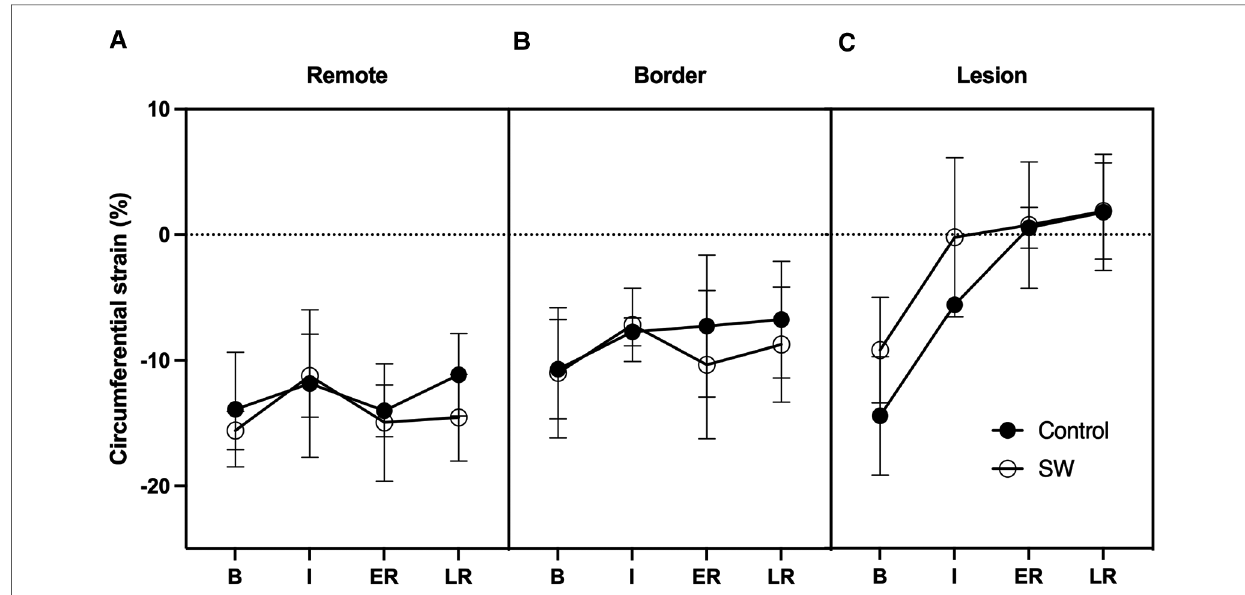
FIGURE 5 Circumferential regional Strains time-course at Baseline ( B ), Ischemia ( I ), Early (ER) and Late Reperfusion (LR) in Control Group (black dots) and SW Therapy group (white dots). Data are provided in remote ( A ), border ( B ) and lesion ( C ) regions of the central SAX